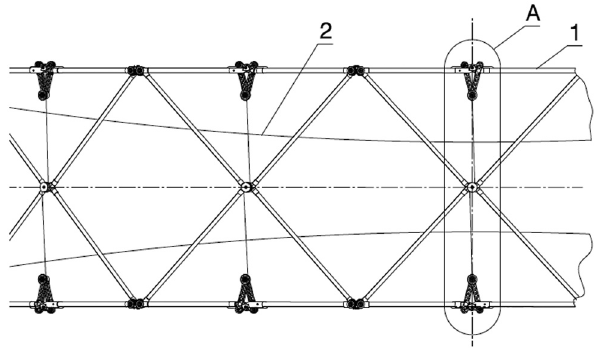
Figure 2: Fragment of the SSAR ( 1 – deployable ring, 2 – network systems, A – V - folding bar units )